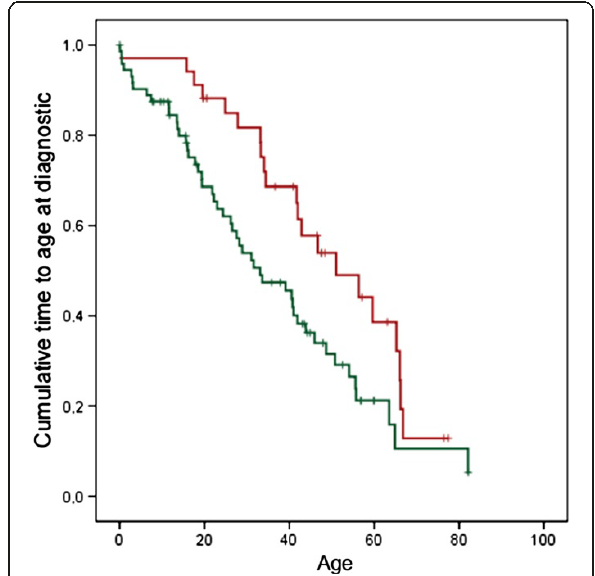
Figure 2 Age at diagnosis of hypertrophic cardiomyopathy. Time free from diagnosis curve. Red graph: group A cases ( MYBPC3 IVS20-2A>G mutation carriers); green graph: group B cases (all other mutation carriers). Log rank test p =